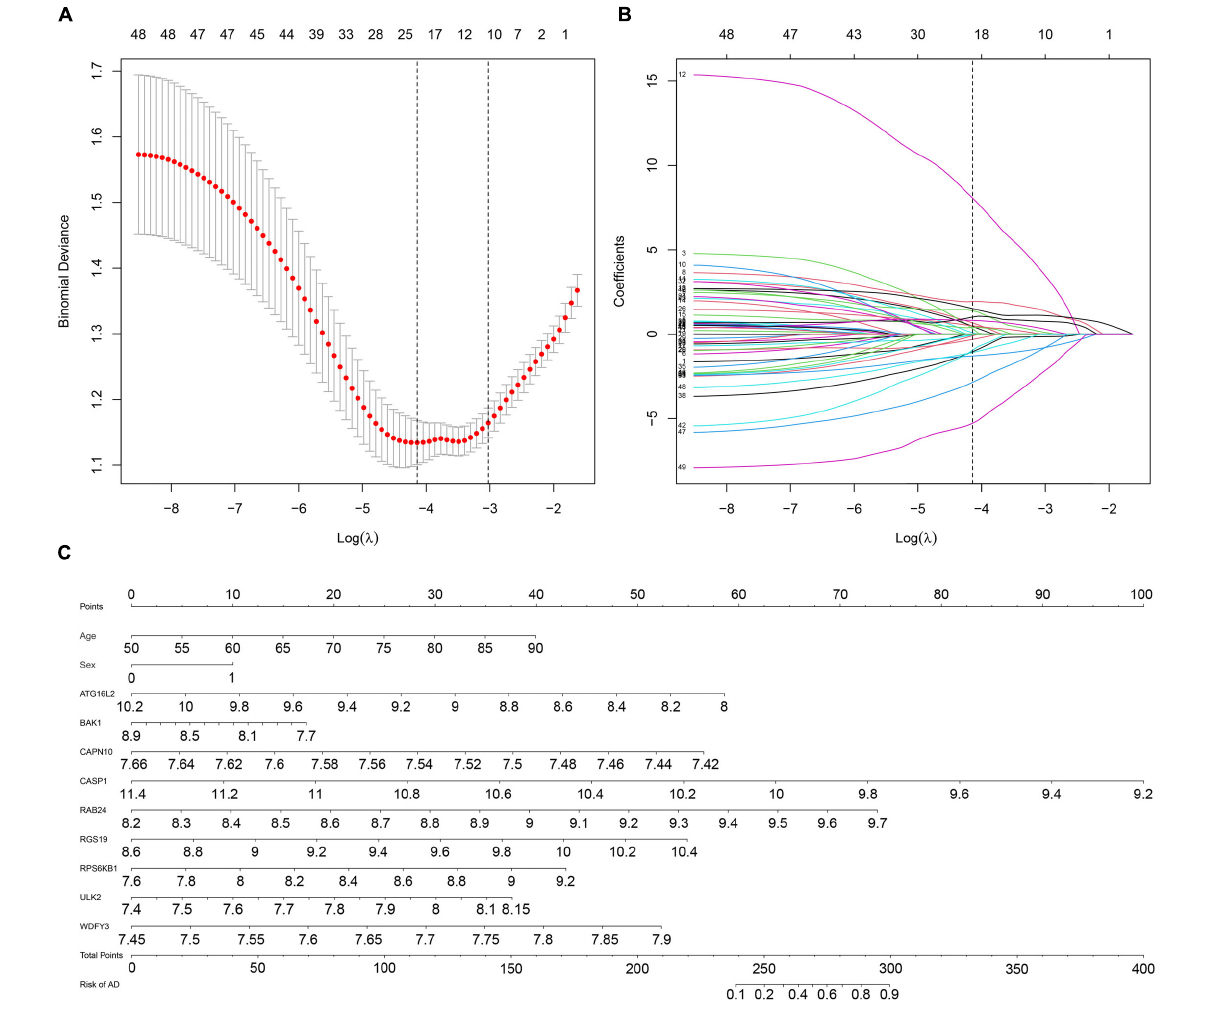
FIGURE 3 | Establishment of a multipredictor nomogram and DE-ATG selection using the LASSO and logistic regression models. (A) Cross-validation to select the most suitable tuning parameter lambda ( λ ); a λ value of 0.014 with log( λ ) being –4.233 was chosen as optimal. The first black dotted line represents those 49 features that were reduced to 22 non-zero coefficient features by LASSO. (B) The coefficients in the LASSO regression model for key DE-ATGs. (C) Predictive nomogram involving age, sex, and the expression profile of 9 DE-ATGs based on selected